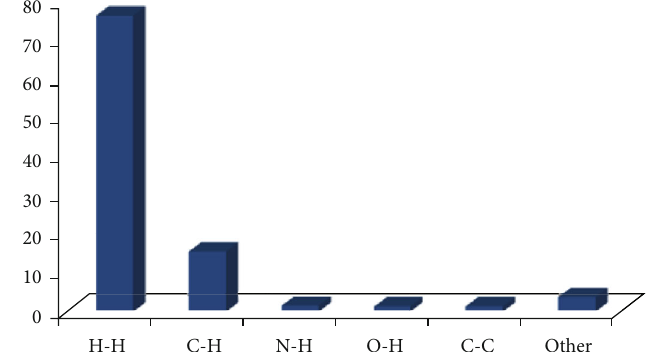
Figure 6: Relative contributions of intermolecular contacts to the HS